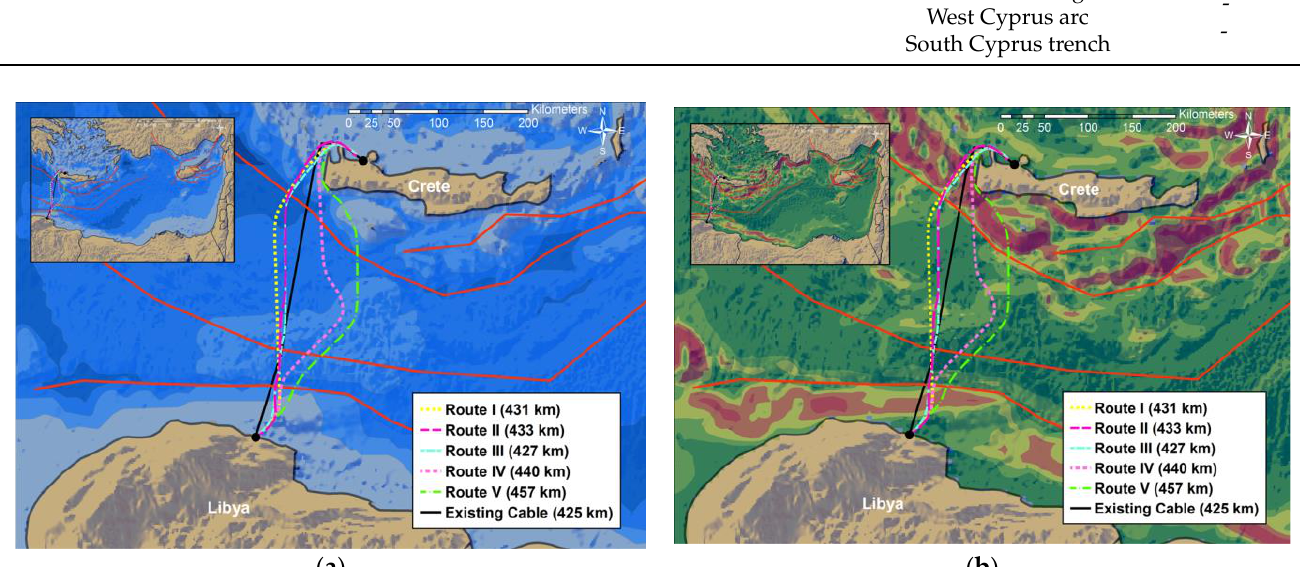
Figure 10. Proposed alternative routes and seismically active fault zones: ( a ) with the bathymetry as a background and ( b ) with the seabed inclination as a background.